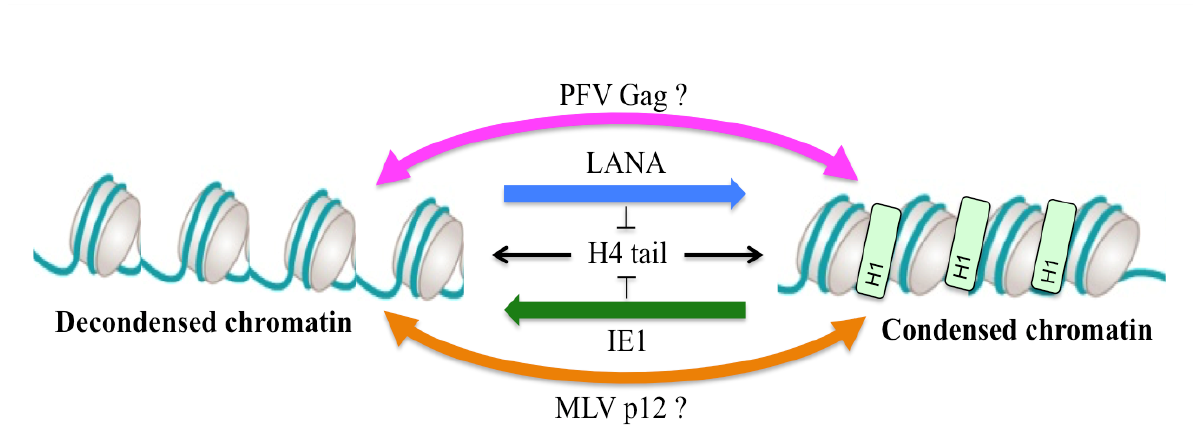
FIGURE 1: Hypothesis model for viral protein mediated chromatin remodeling. The ground state chromatin structure is mediated by H4 tail binding to the acidic patch. Alteration of the chromatin state can be achieved by competition of viral proteins with H4 tail for binding to the acidic patch leading to a viral replication-permissive chromatin structure. Abbreviations: H1, histone H1. H4, histone H4. See text for